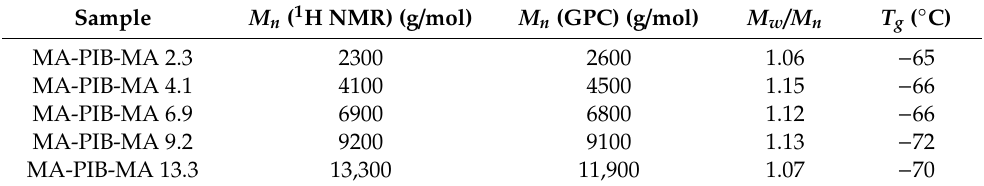
Table 1. The number average molecular weights ( M n ) by 1 H NMR spectroscopy and GPC, the polydispersities ( M w / M n ), and the glass transition temperatures ( T g ) of methacrylate-telechelic polyisobutylenes (MA-PIB-MAs).